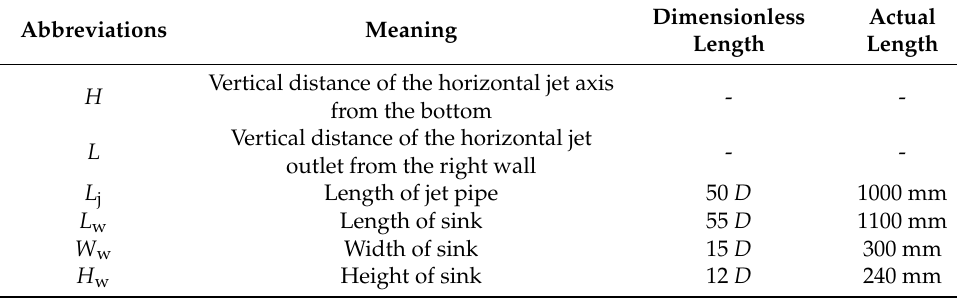
Figure 1. Schematic diagram of the three-dimensional horizontal submerged jet. Table 1. Detailed dimensions of the computational